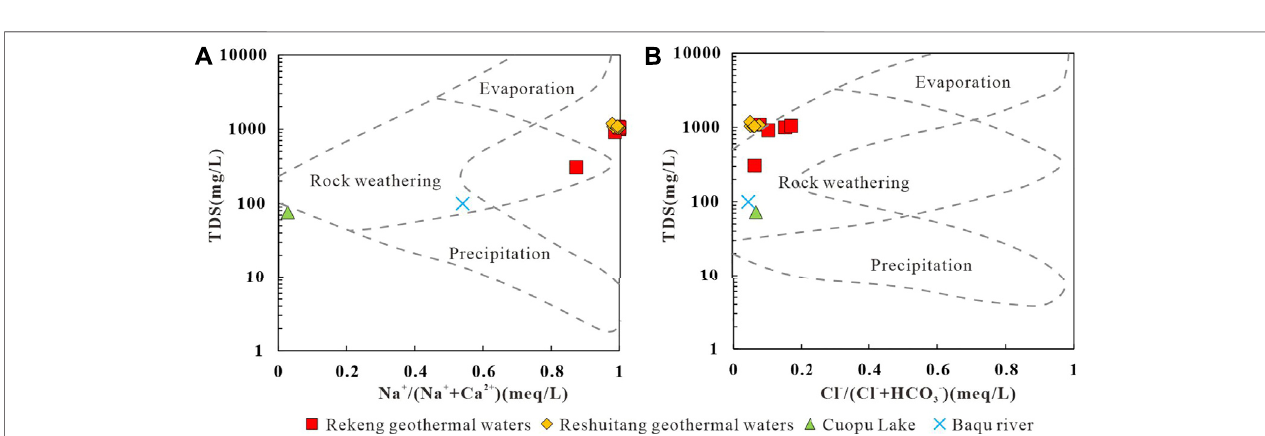
FIGURE 5 | Gibbs illustration of water samples in the study area. Rock weathering: the hydrochemical composition within the region is mainly in fl uenced by rock weathering and dissolution; Evaporation: the hydrochemical composition within the region is mainly in fl uenced by evaporation and concentration; Precipitation: the hydrochemical composition within the region is mainly in fl uenced by atmospheric precipitation